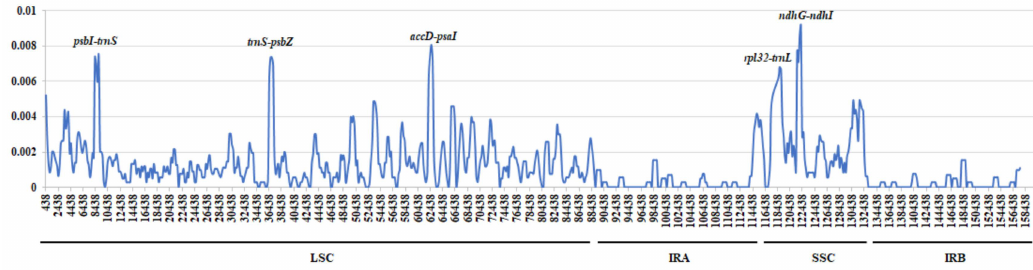
Figure 6. Nucleotide diversity graphs of nine Epimedium plastid genomes. The x -axis represents position of the midpoint of a window, and the y -axis represents Pi